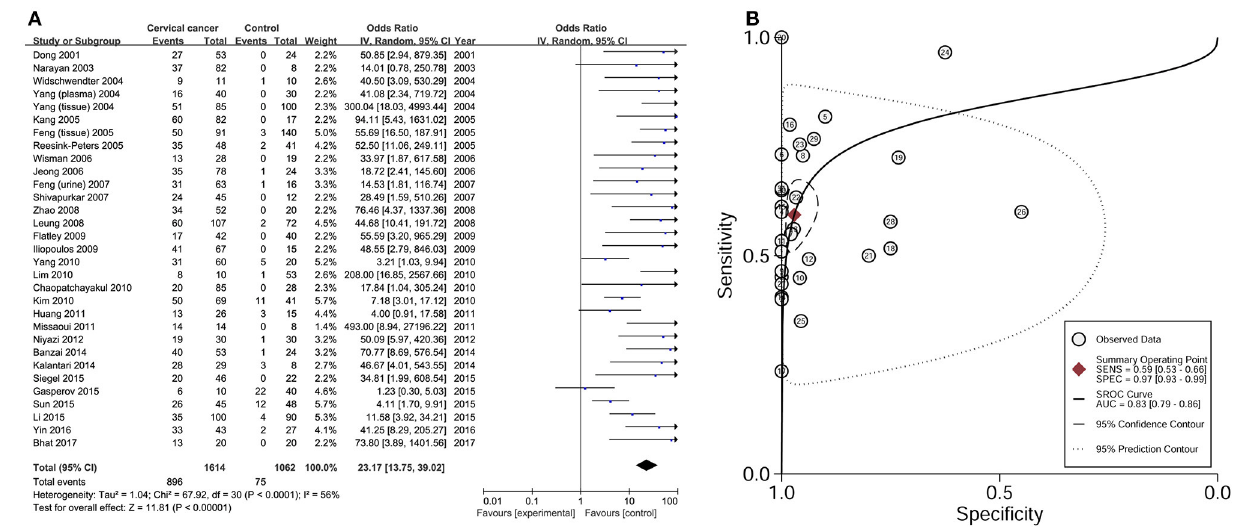
FIGURE 4 | Risk assessment and diagnostic value of DAPK1 promoter hypermethylation in CC. (A) Meta-analyses for the association between DAPK1 promoter hypermethylation and CC risk; (B) SROC curves showing the diagnostic value of DAPK1 methylation detection in CC. CC, cervical cancer; SROC, Summary receiver operating characteristic.